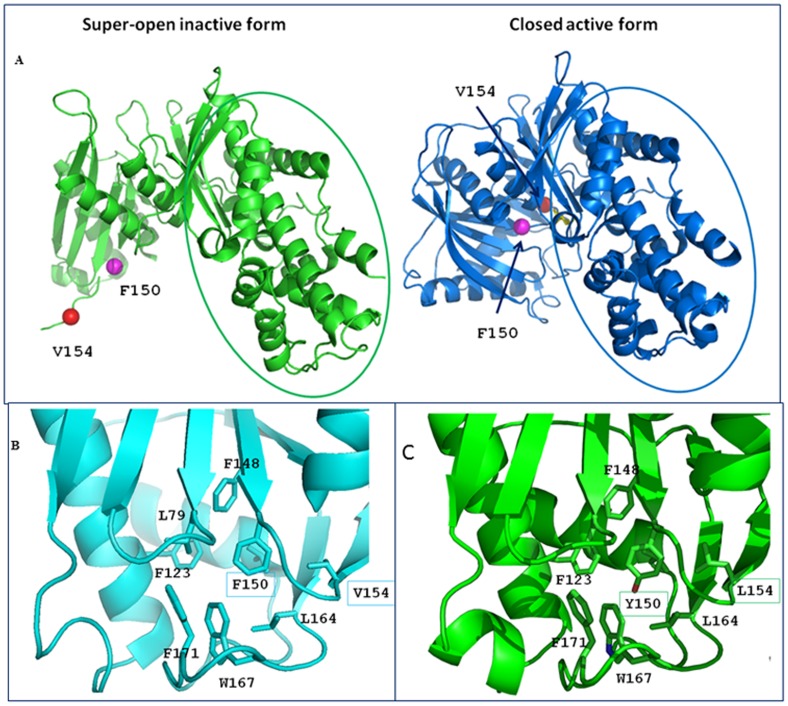
View of the mutations p.Phe150Tyr and p.Val154Leu in the whole structures and in their local environment. A: The structures of GCK in the super-open inactive form (PDB code code: 1v4t) and in the closed active form (PDB code code: 1v4s) are shown on the left and on the right, respectively. In the closed form (right) the sugar is shown as a yellow stick. In both panels, the large domain is in the same orientation and is circled. It is clear that the small domain undergoes a large conformational variation from the super-open to the closed form. Specifically the region embodying the residues Phe150 (blue sphere) and Val154 (red sphere) dramatically changes its orientation. B: Close-up view of the wild-type closed structure showing the hydrophobic core rich in aromatic/hydrophobic amino acids. Leu79, Phe123, Phe148, Phe150, Val154, Leu164, Trp167 and Phe171 form an intricate network of stabilizing hydrophobic interactions. C: Structure of GCK closed structure containing the both the Tyr150 and Leu154 mutated residues. Introduction of the oxydryl group (red) of Tyr150 within the hydrophobic core disrupts the interactions present in the wt-enzyme. The replacement of Val154 by leucine produces only small changes in the closed form.